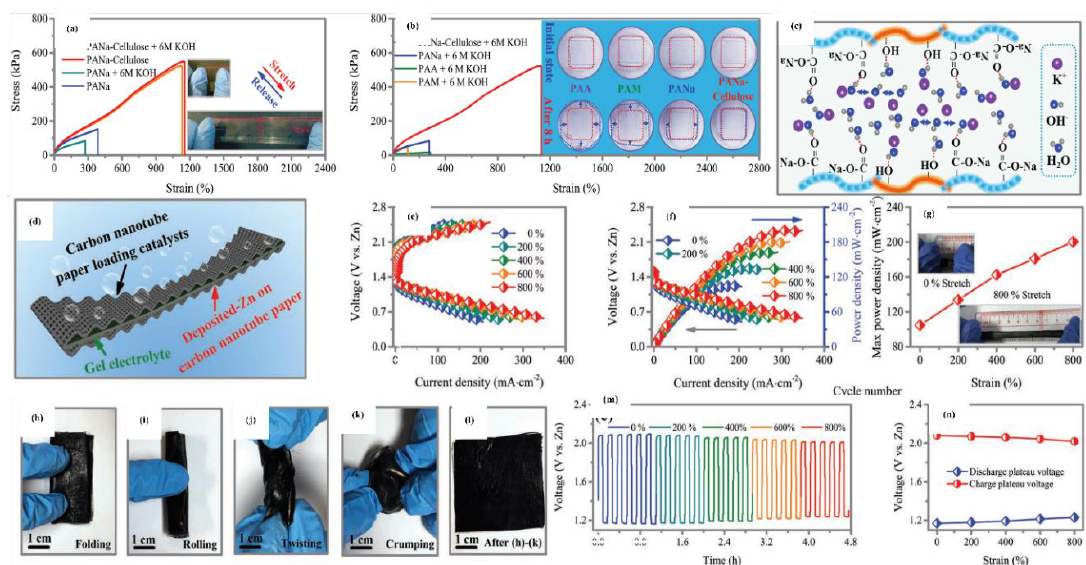
Figure 28. ( a ) Tensile stress–strain curves of the as-synthesized PANa and PANa-cellulose hydrogel electrolytes with and without 300% 6 M KOH + 0.2 M Zn (CH 3 COO) 2 intake. The insets are optical photos of the relaxed and elongated states of the 300% 6 M KOH + 0.2 M Zn (CH 3 COO) 2 solution-incorporated PANa-cellulose hydrogel electrolytes showing excellent stretchability; ( b ) comparison of tensile properties of poly (acrylic acid) PAA, poly (acrylamide) PAM, sodium polyacrylate, PANa and PANa-cellulose hydrogel under alkaline condition. The inset is the photos of PAA, PAM, PANa and PANa-cellulose hydrogel at initial state and containing 300% 6M KOH solution for 8 h. The red and blue rectangles represent the shape of hydrogel before and after infiltrating alkaline solution, respectively; ( c ) schematic diagram reflecting structure of PANa-cellulose hydrogel electrolyte entrapped KOH and water via the interactions of hydrogen bonds; ( d ) schematic illustration of 800% stretchable flat-shape zinc–air battery; ( e ) polarization curves; ( f ) corresponding power density curves of the flat-shape highly stretchable zinc–air battery with a strain from 0 to 800%; ( g ) maximum power density as a function of the tensile strain. The insets are the photographs of the flat-shaped zinc–air battery at a fully released state and 800% strain; ( h – k ) flat-shape zinc–air battery is subjected to different mechanical deformations sequentially and ( l ) released; ( m ) galvanostatic discharge–charge cycling curves at a current density of 5 mA·cm −2 and ( n ) corresponding discharging-charging voltage plateau at different stretching strains [210].